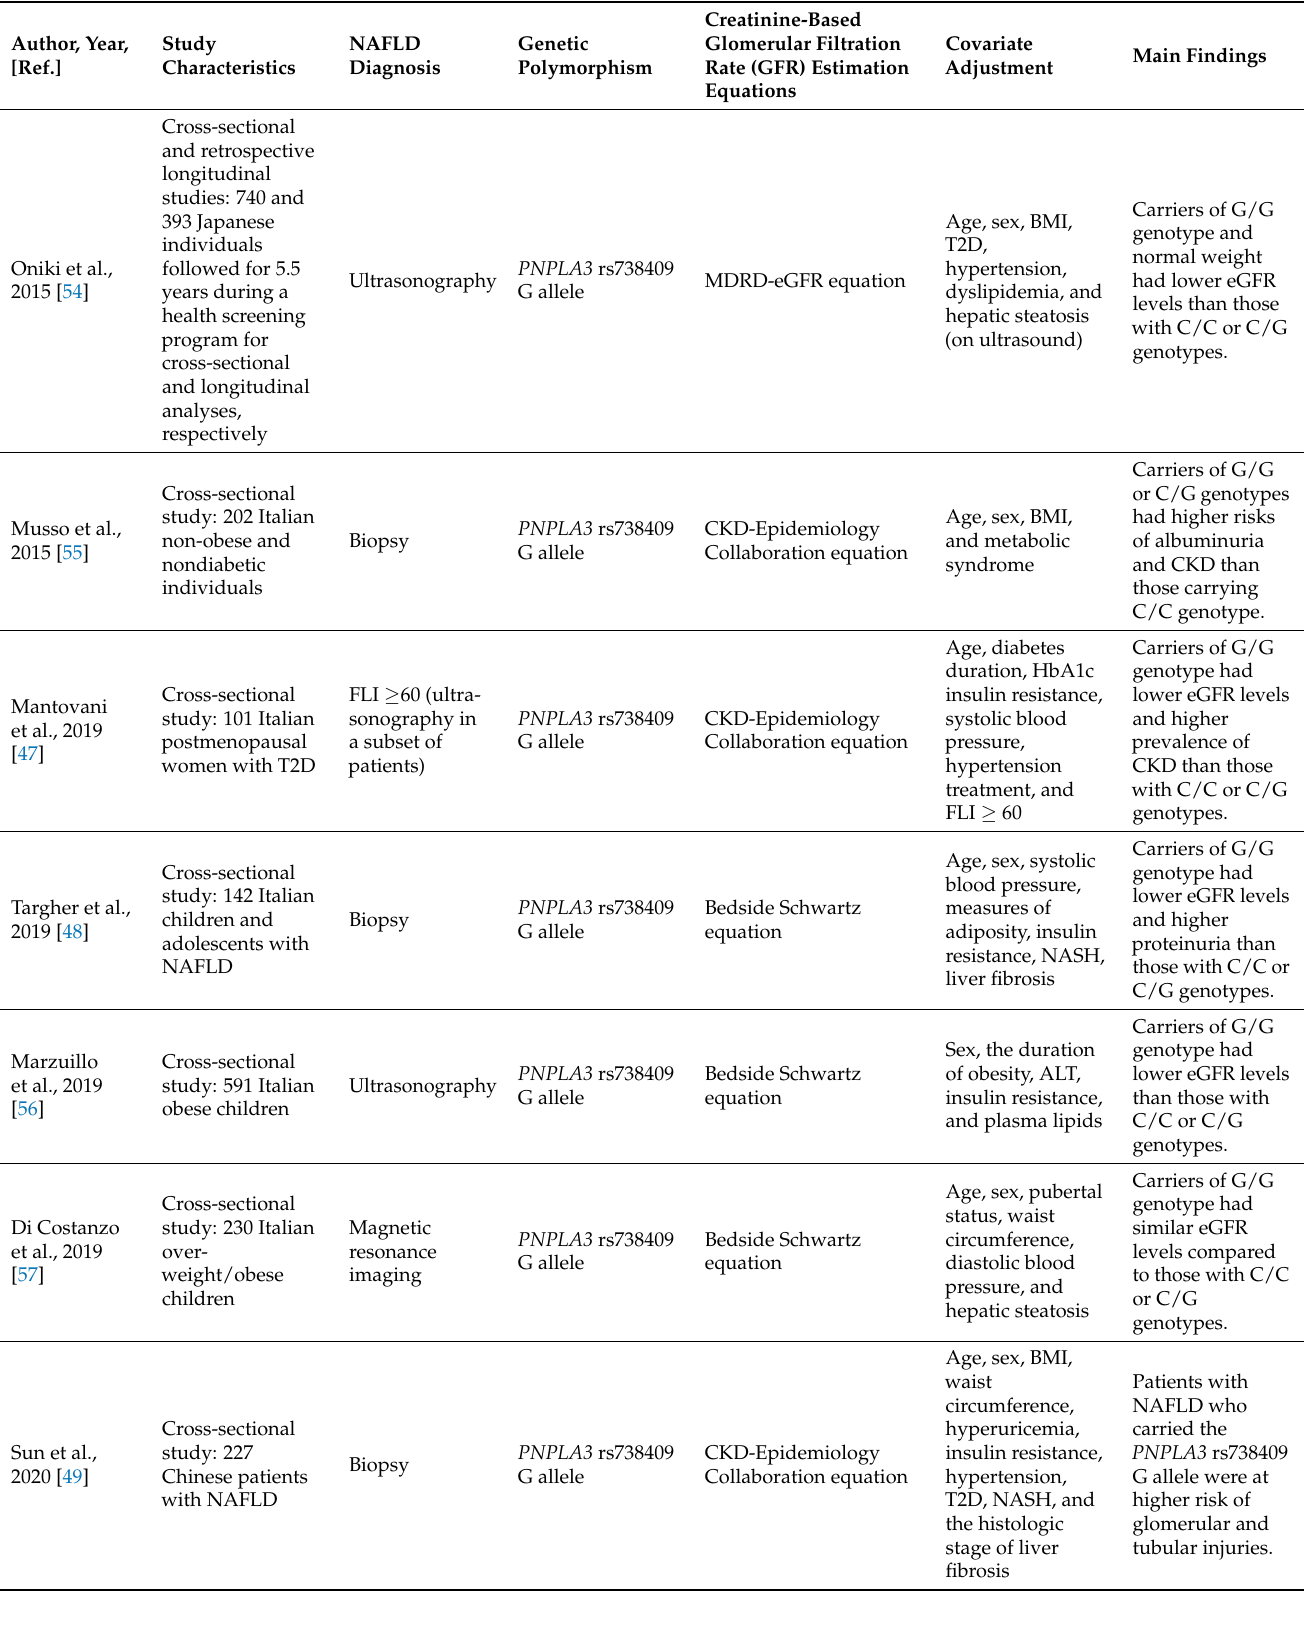
Table 1. Observational studies examining the associations between specific polymorphisms related to the development and progression of NAFLD and the risk of